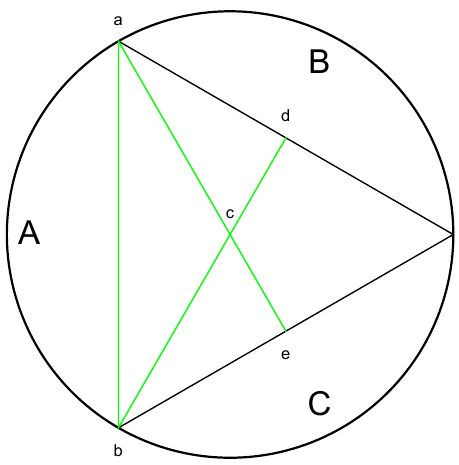
ph for tripartite pure state. Beltrami-Klein coordinates